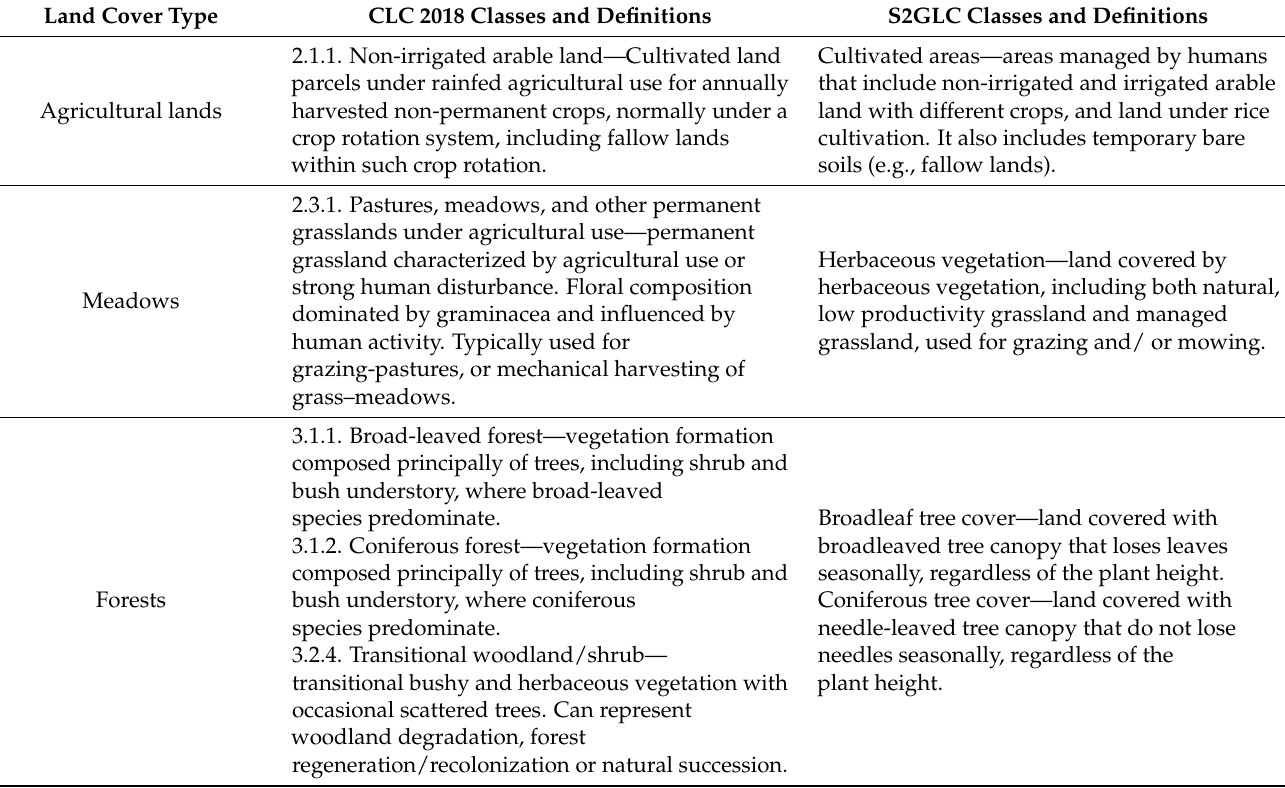
Table 1. Classes used to compute land cover metrics and their